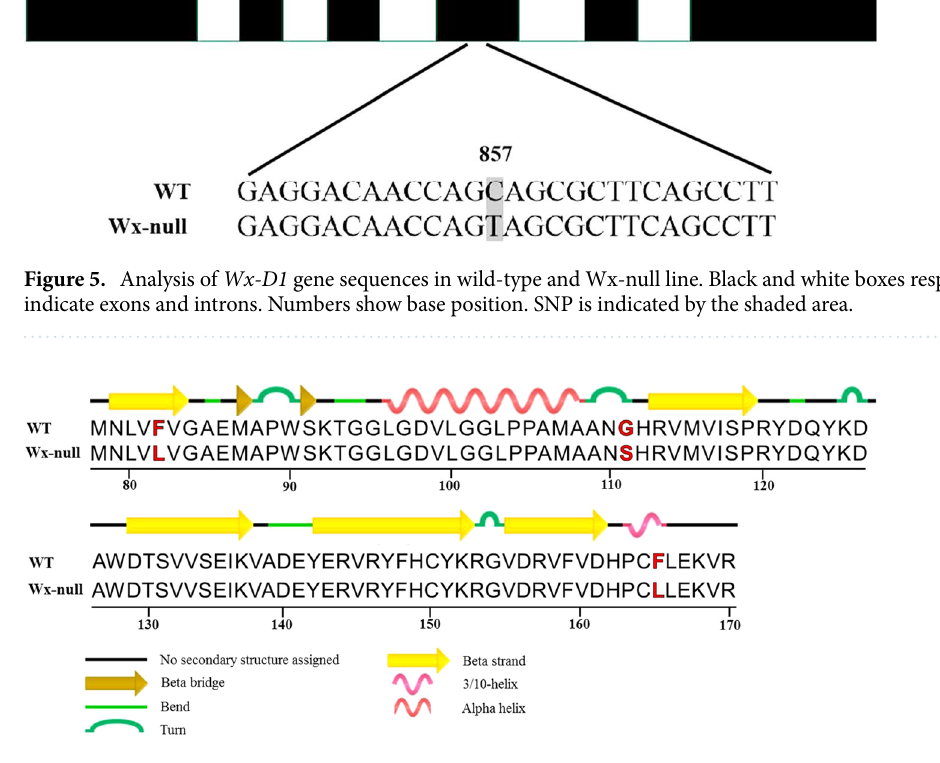
Figure 6. Protein sequence alignment and structural analysis. Numbers show residue position. Amino acid polymorphism is indicated by the red